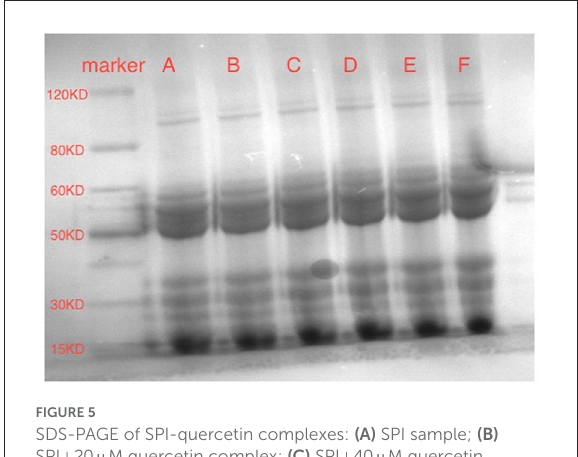
FIGURE5 SDS-PAGE of SPI-quercetin complexes: (A) SPI sample; (B) SPI + 20 µ M quercetin complex; (C) SPI + 40 µ M quercetin complex; (D) SPI + 60 µ M quercetin complex; (E) SPI + 80 µ M quercetin complex; (F) SPI + 100 µ M Que.